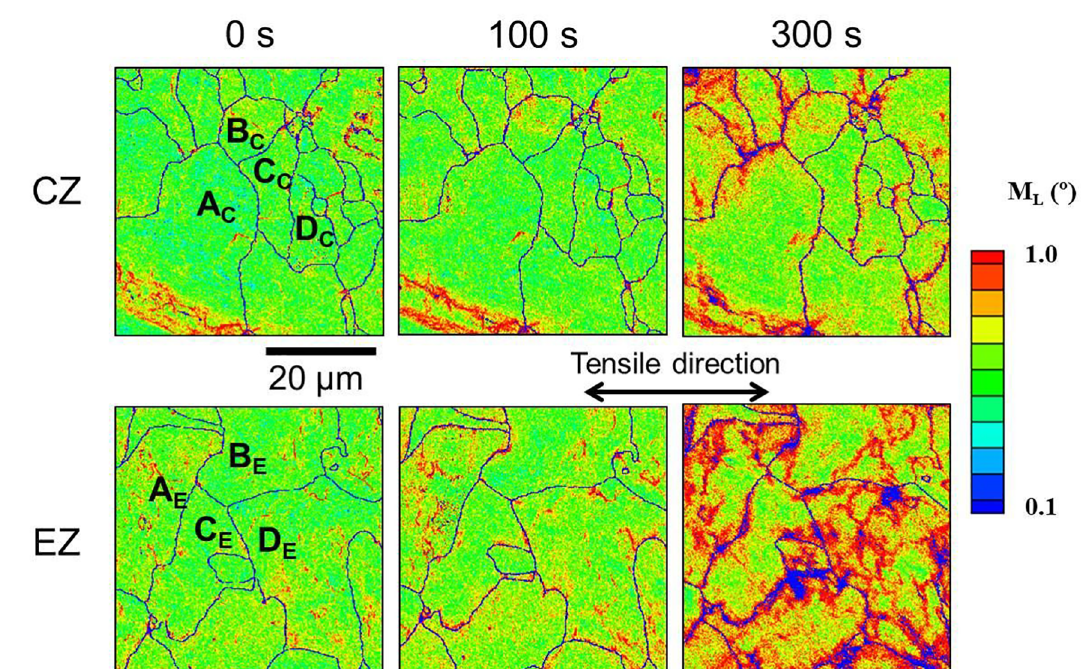
maps (logarithmic scale) obtained in CZ and EZ after each stage, indicating the grain boundaries to be Figure 7. M L